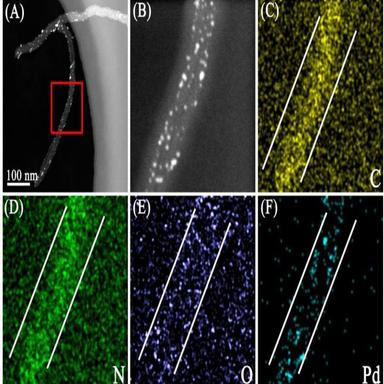
HAADF-STEM image of Pd/CNTs-DPHE-2 and corresponding EDS mapping results for C, N, O and Pd elements, respectively.